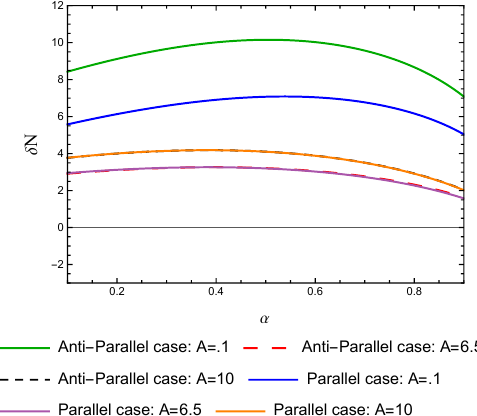
Figure 13 . Parallelly accelerating and Anti-parallelly accelerating detectors in (1 + 3) dimensions: δ N VS α plot for different fixed values of A with ∆ E B